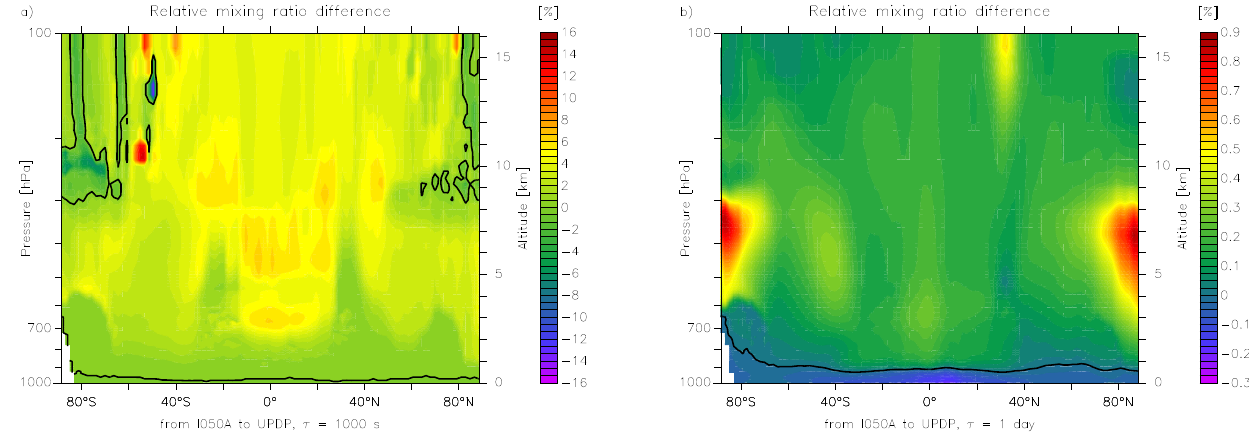
Figure 5. Relative difference in zonally and 2001 averaged mixing ratios for UPDP compared to I050A. Results are shown for the tracers with lifetimes of (a) 1000s and (b) 1 day.